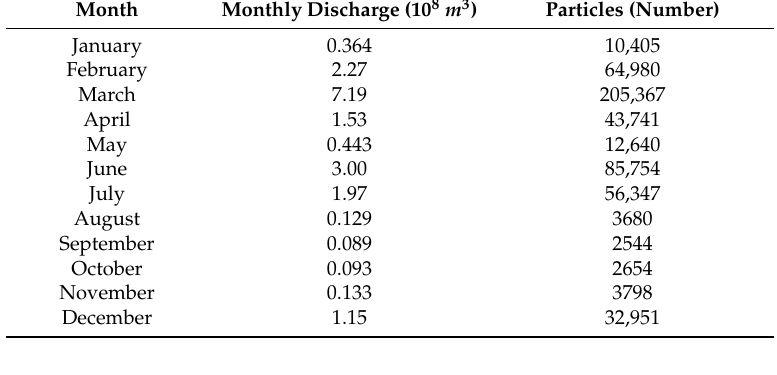
Table 1. The number of new particles released and the total water volume input from the Sandusky River in each month.